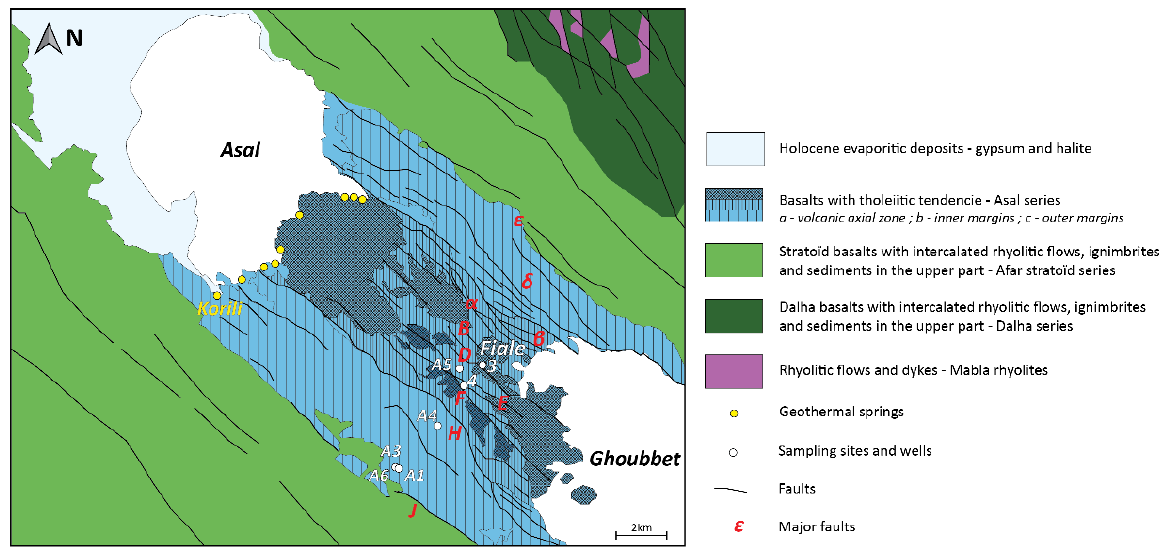
Figure 4. Geological and structural map of the Asal–Ghoubbet Rift. Major fault names are shown in red (Greek alphabet in the northeast and Latin in the southwest), Asal hot springs in yellow (modified from [64,66]) and wells in white.